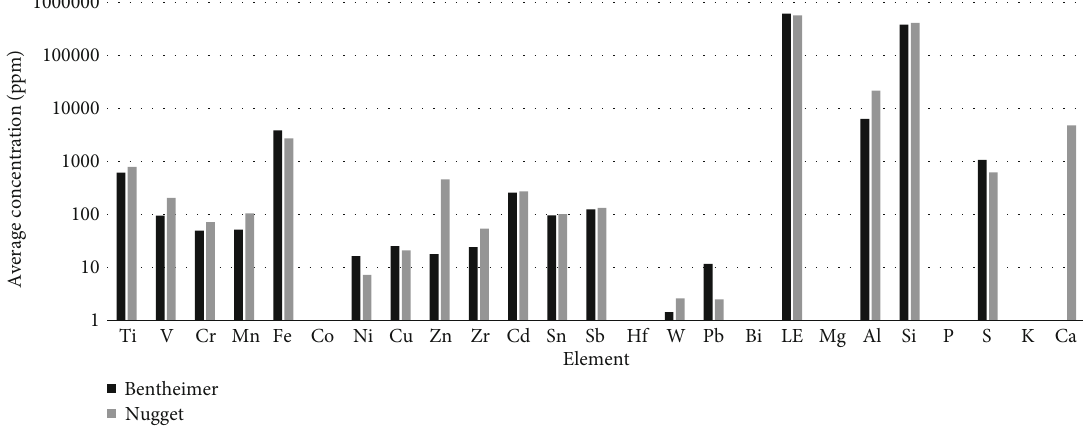
Figure 3: X-ray fl uorescence elemental compositions. LE are light elements not captured by the XRF measurement. See Mackey et al. [24] for equipment details. Table 1: Cyclic drainage-imbibition scCO